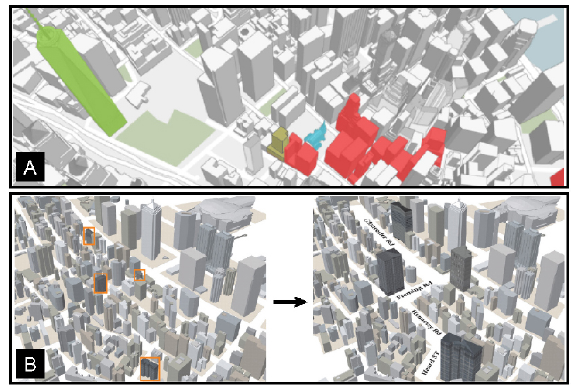
Fig. 3 (A) Users can perceive the impact of new buildings on urban space in a 3D environment. (B) 3D urban space is deformed to highlight target buildings. Reproduced with permission from Ref. [124] for (A), c (cid:13) IEEE 2015; Ref. [123] for (B), c (cid:13) IEEE